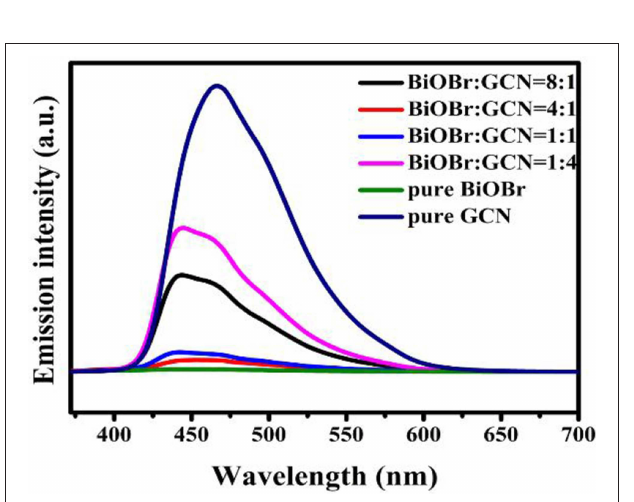
FIGURE 6 | Transient photocurrent of pure BiOBr and g-C 3 N 4 , BiOBr-g-C 3 N 4 composites.